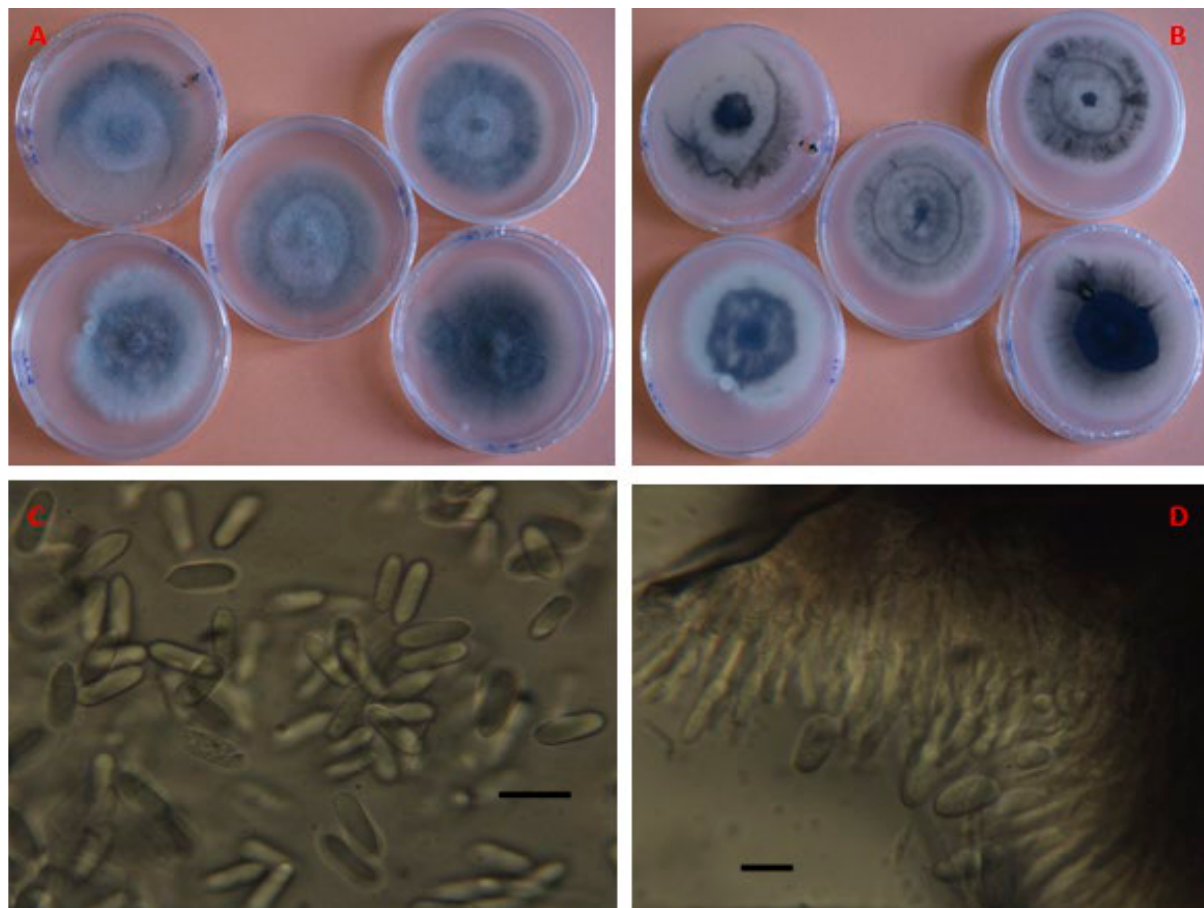
Figure 2. Cultural and microscopic characters of Colletotrichum gloeosporioides isolated from orange leaves after 7 days on PDA. A, culture on PDA (upper surface); B, culture on PDA (reverse surface); C, conidia ( × 600); D, acervulus and conidi- ophores bearing condia. Bars= 20